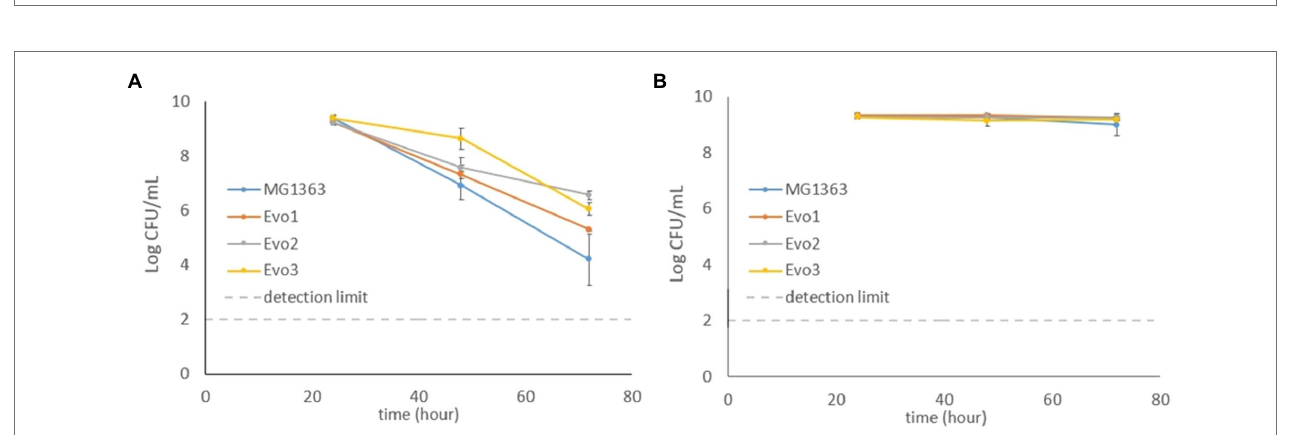
FIGURE 2 | Growth curves based on optical density (OD) of MG1363 and evolved strains under (A) static fermentation, (B) aerated, and (C) respiration-permissive conditions in GM17 media at 30°C. Data from biological triplicates, error bars represent SD.